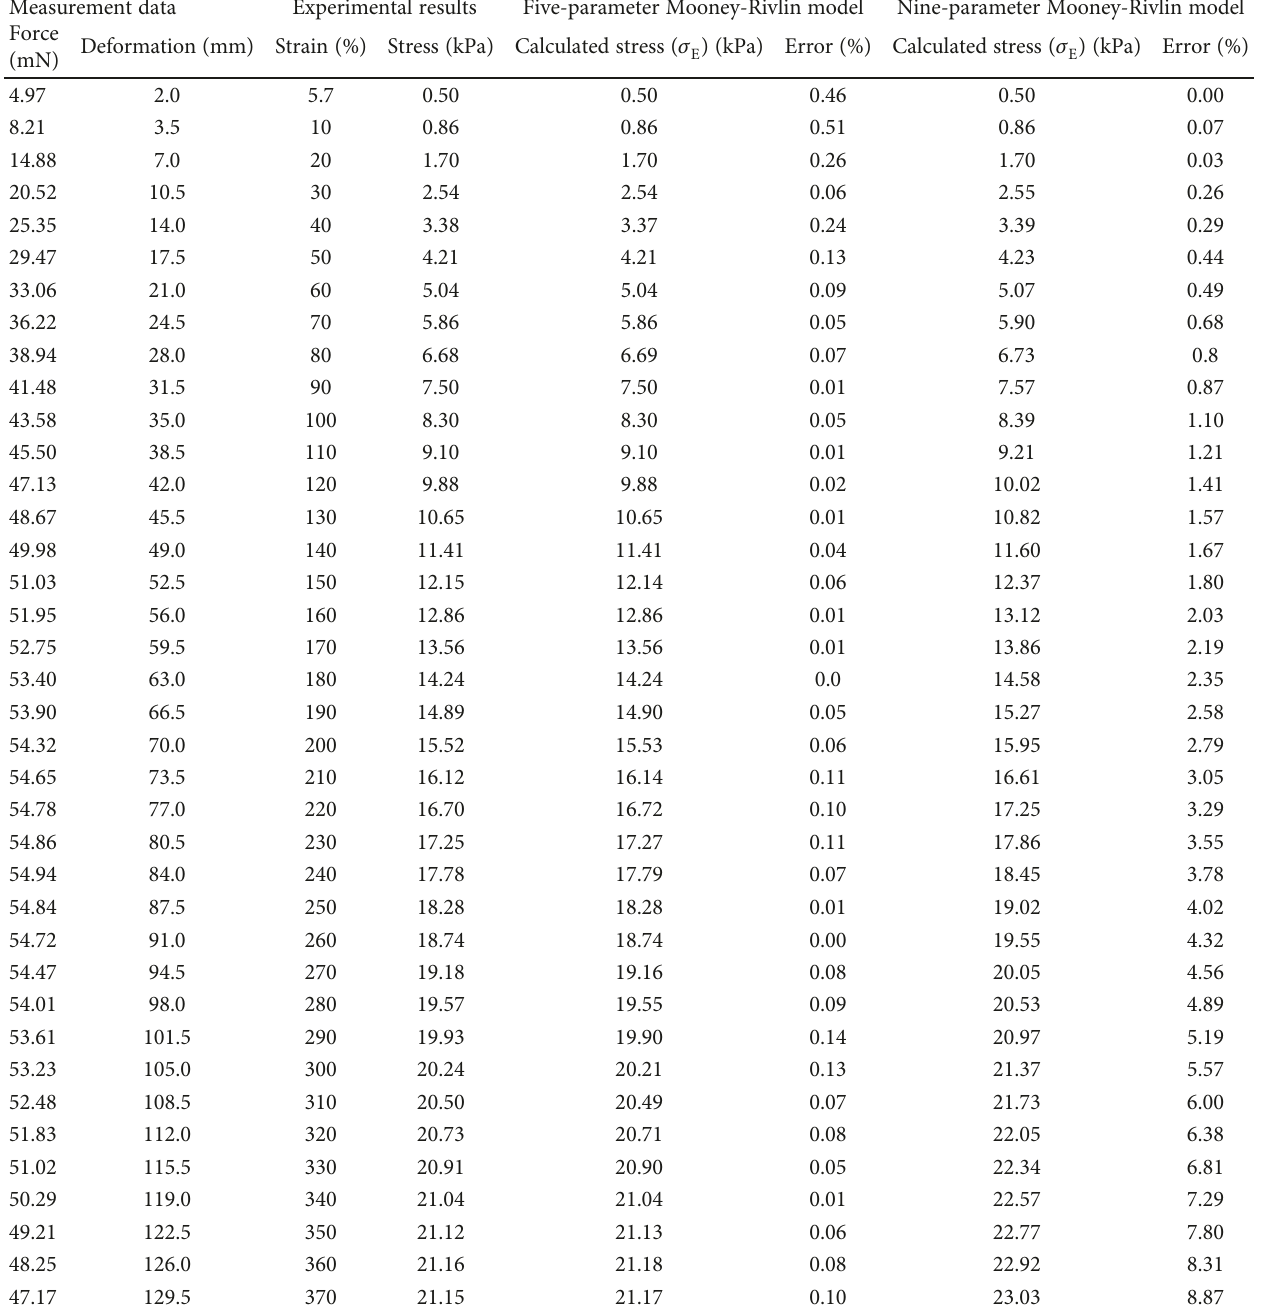
Table 1: Comparison of the calculated tensile stress with the experimental data from the uniaxial tensile test. Measurement